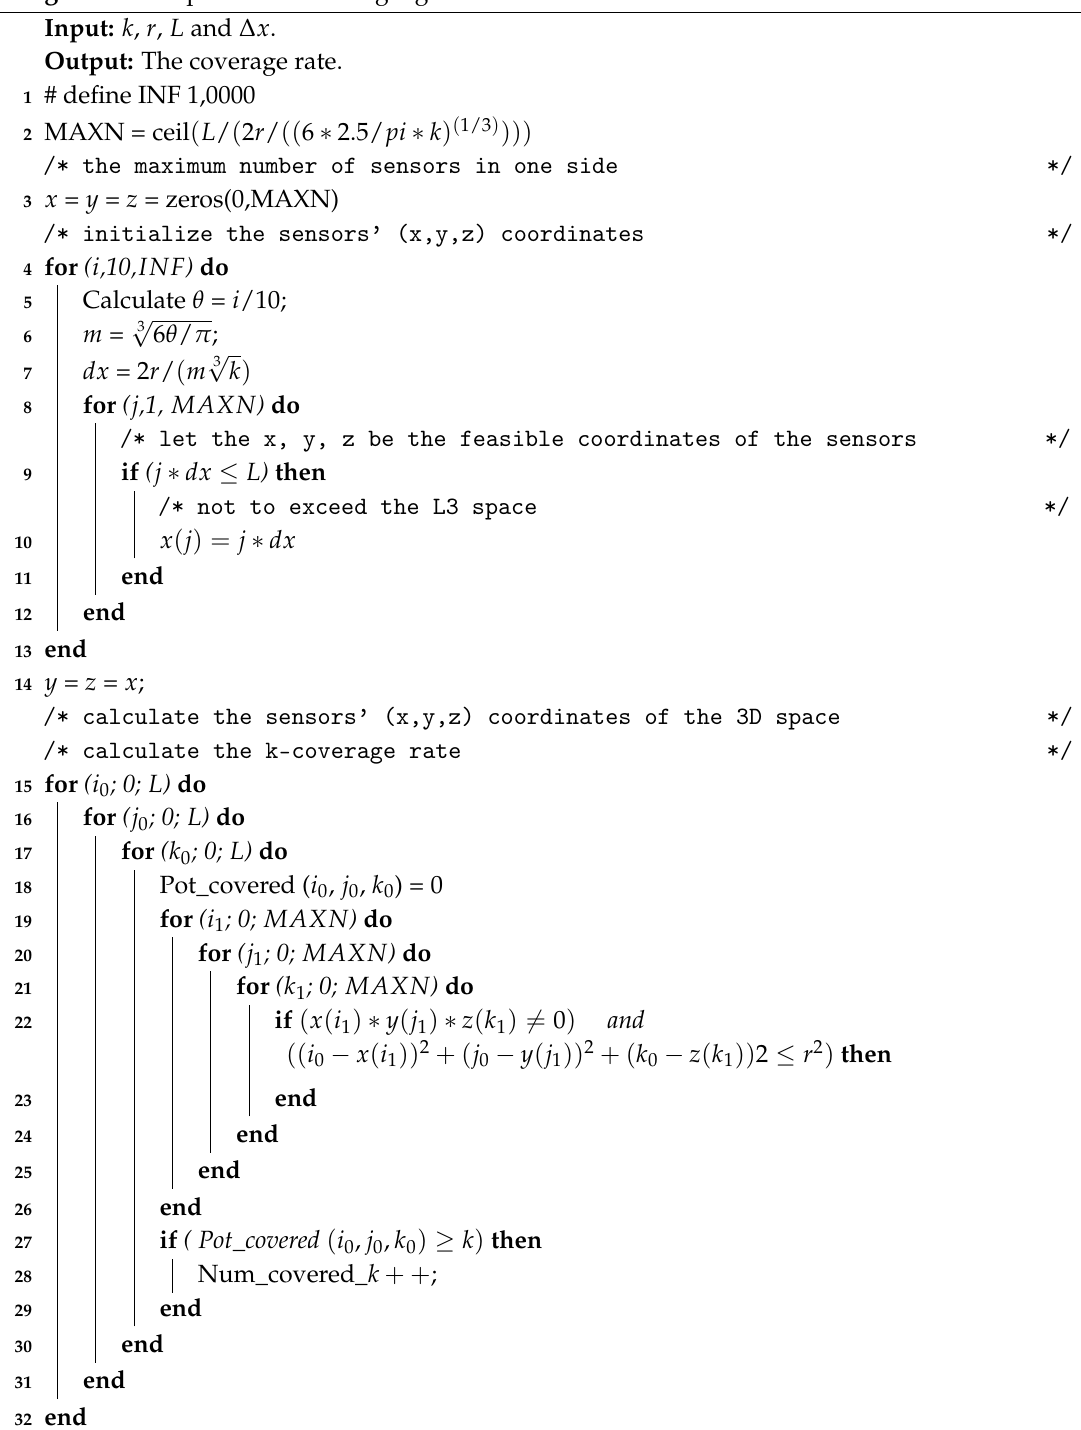
Algorithm 1: Optimal θ searching